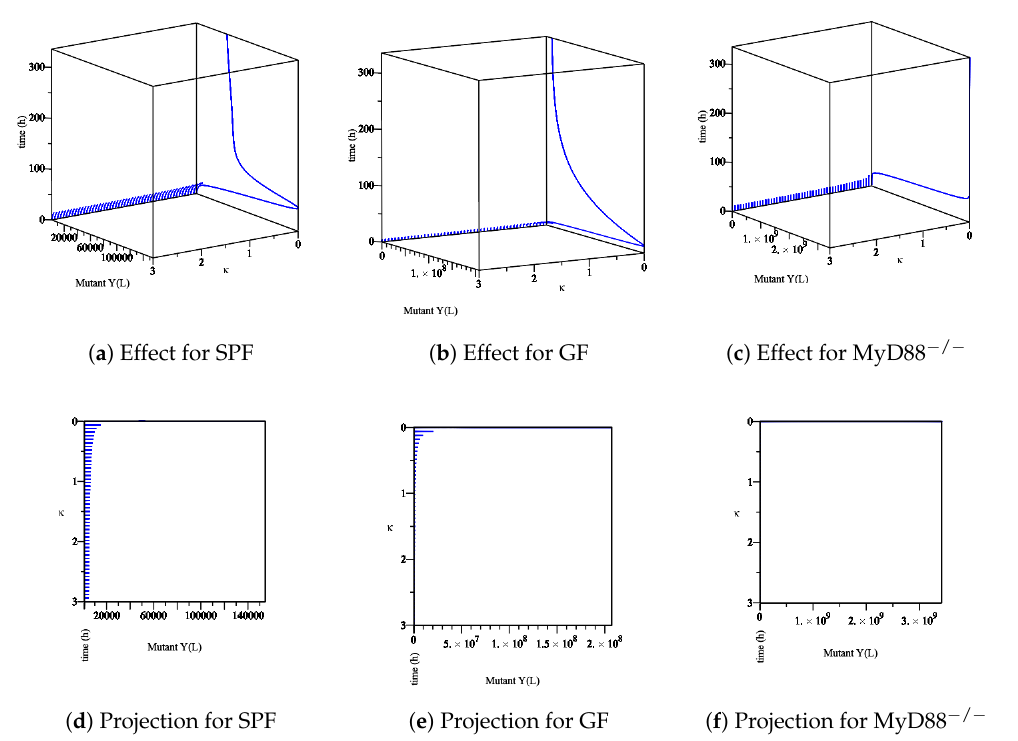
Figure 10. The sensitivity of the parameter κ in the elimination of the mut Yersinia strain in the lumen. ( a – c ) The effect of the parameter κ on the different types of mice. ( d – f ) The projection of κ for different types of